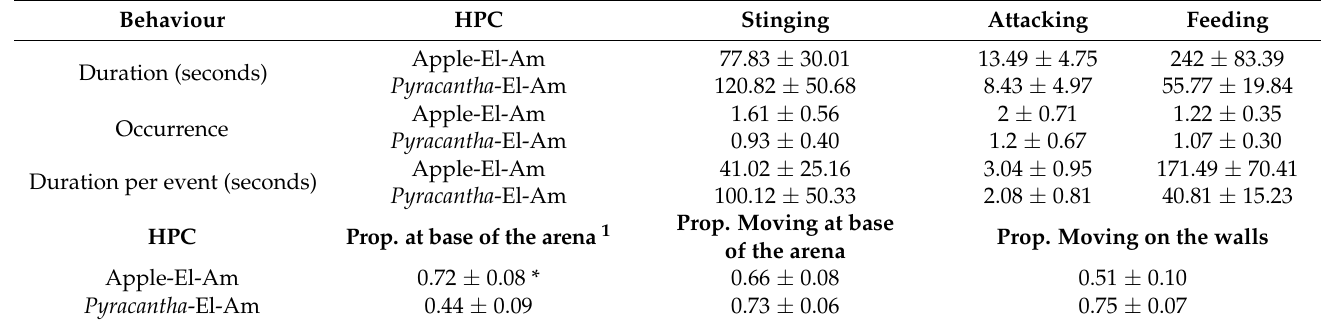
Prop. Moving on the